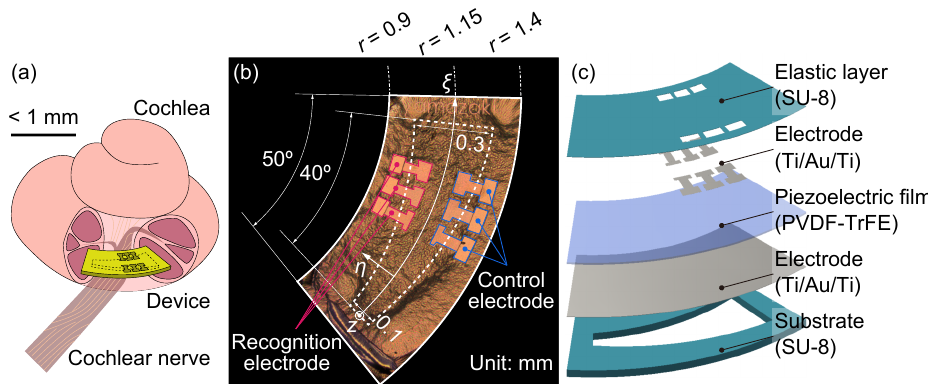
Figure 2. ( a ) Schematic of a miniaturized artificial cochlear sensory epithelium for in vivo experiments. The device is designed to be implanted in the cochlea to develop a fully insertable cochlear implant. ( b ) Photomicrograph of the miniaturized device. Recognition electrodes for measuring the piezoelectric output and control electrodes for applying electrical potential to amplify oscillations are deposited with reference to our previous researches [10,17,18]. ( c ) Configuration of the device. The piezoelectric effect generates potential differences that are used to electrically stimulate the auditory nerve in an attempt to restore